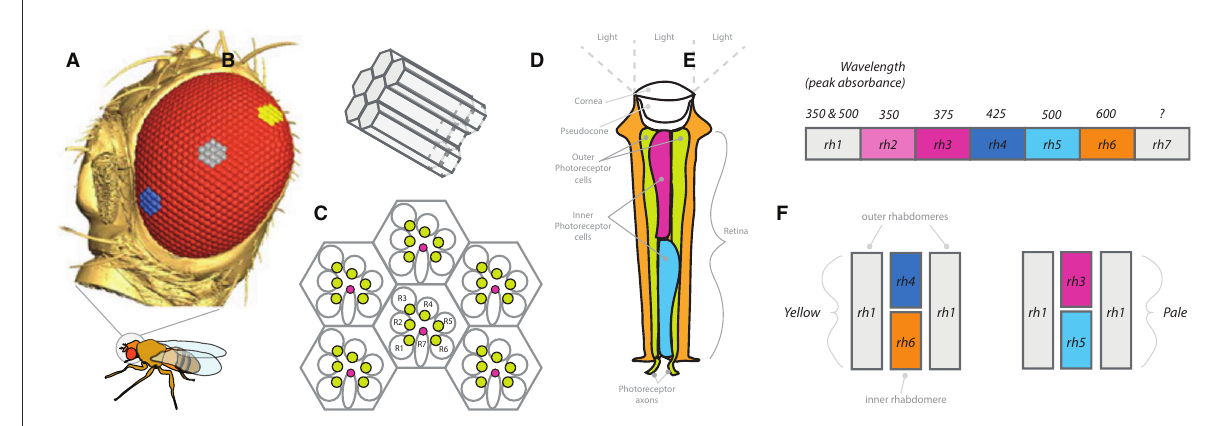
FIGURE6 Compound eye and peripheral visual sensory system. (A) Side view of Drosophila head, showing compound eye (red) and hexagonal ommatidium (blue, grey and yellow cluster examples). Size, distribution, and number of ommatidia can vary widely across Drosophila species (as well as across populations or strains). (B) Single cluster of ommatidia that receives light stimulation within the rhabdomere to activate photoreceptor neurons. (C) Example arrangement of clusters of ommatidia with rhabdomeres (R1-R7), where R1-R6 relate to outer photoreceptor neurons, while R7 represents the inner photoreceptor neuron. (D) Diagram of a single ommatidium. (E) Each ommatidium contains combinations of rhodopsins (rh1-rh7), where these combinations determine wavelength of light absorbance spectrums for that particular photoreceptor. (F) Examples of pale and yellow ommatidium subtypes.